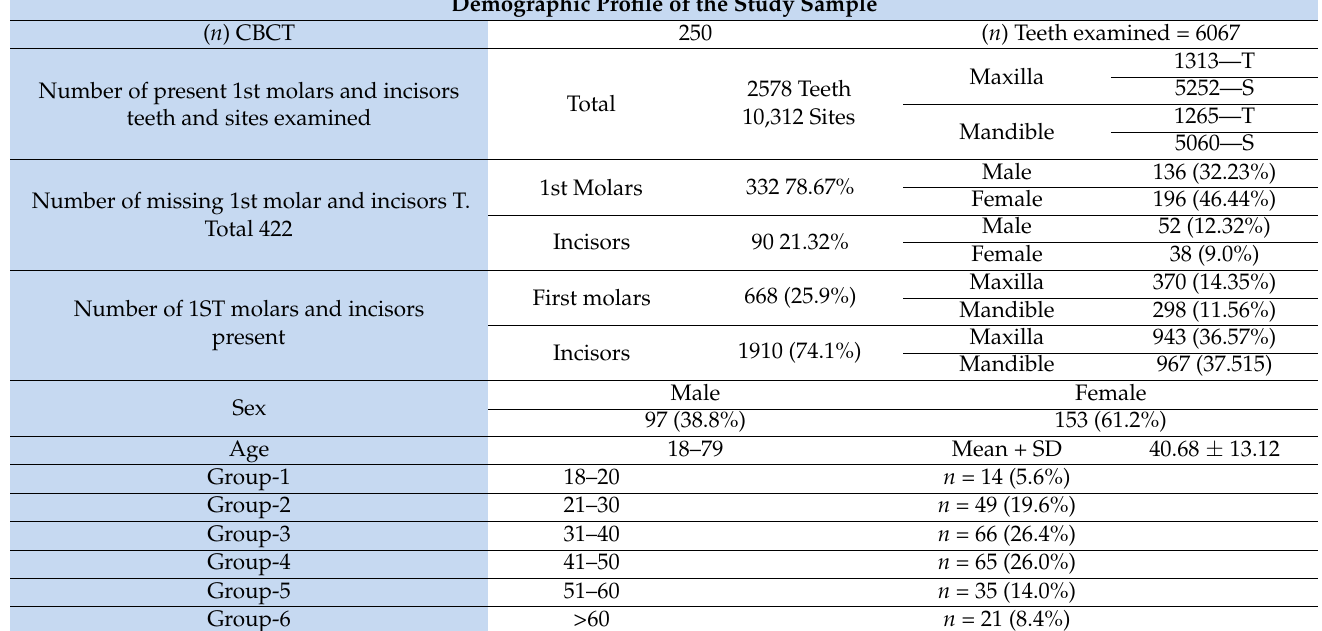
Table 1. Demographic profile of the study sample.